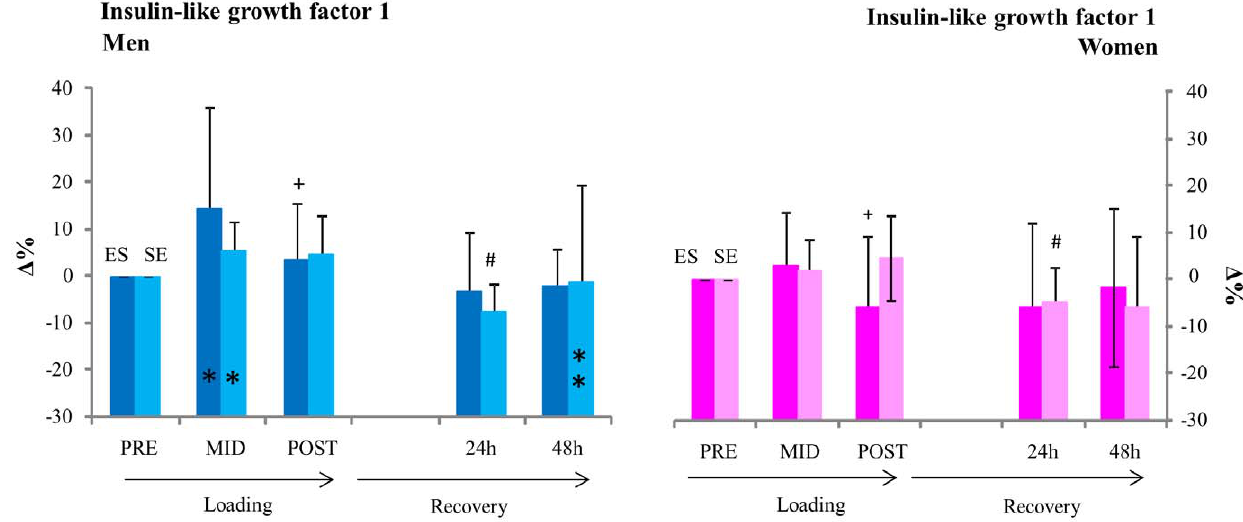
Figure 6. Insulin like growth factor 1. * inside column=significant change (p , 0.05) from pre in absolute GH concentrations, + =significant change (p , 0.05) in absolute IGF-1 from mid, # =significant change (p , 0.05) in absolute IGF-1 from